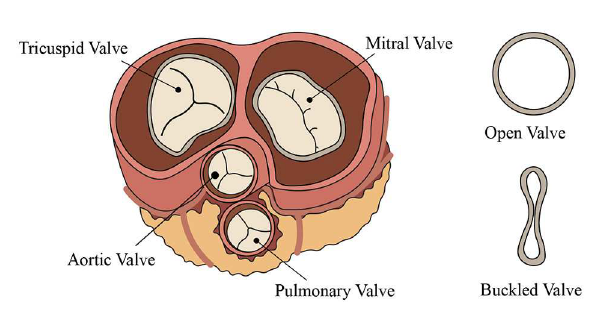
FIGURE1 Schematic representation of heart valves (left) and their possible buckled configuration (right)